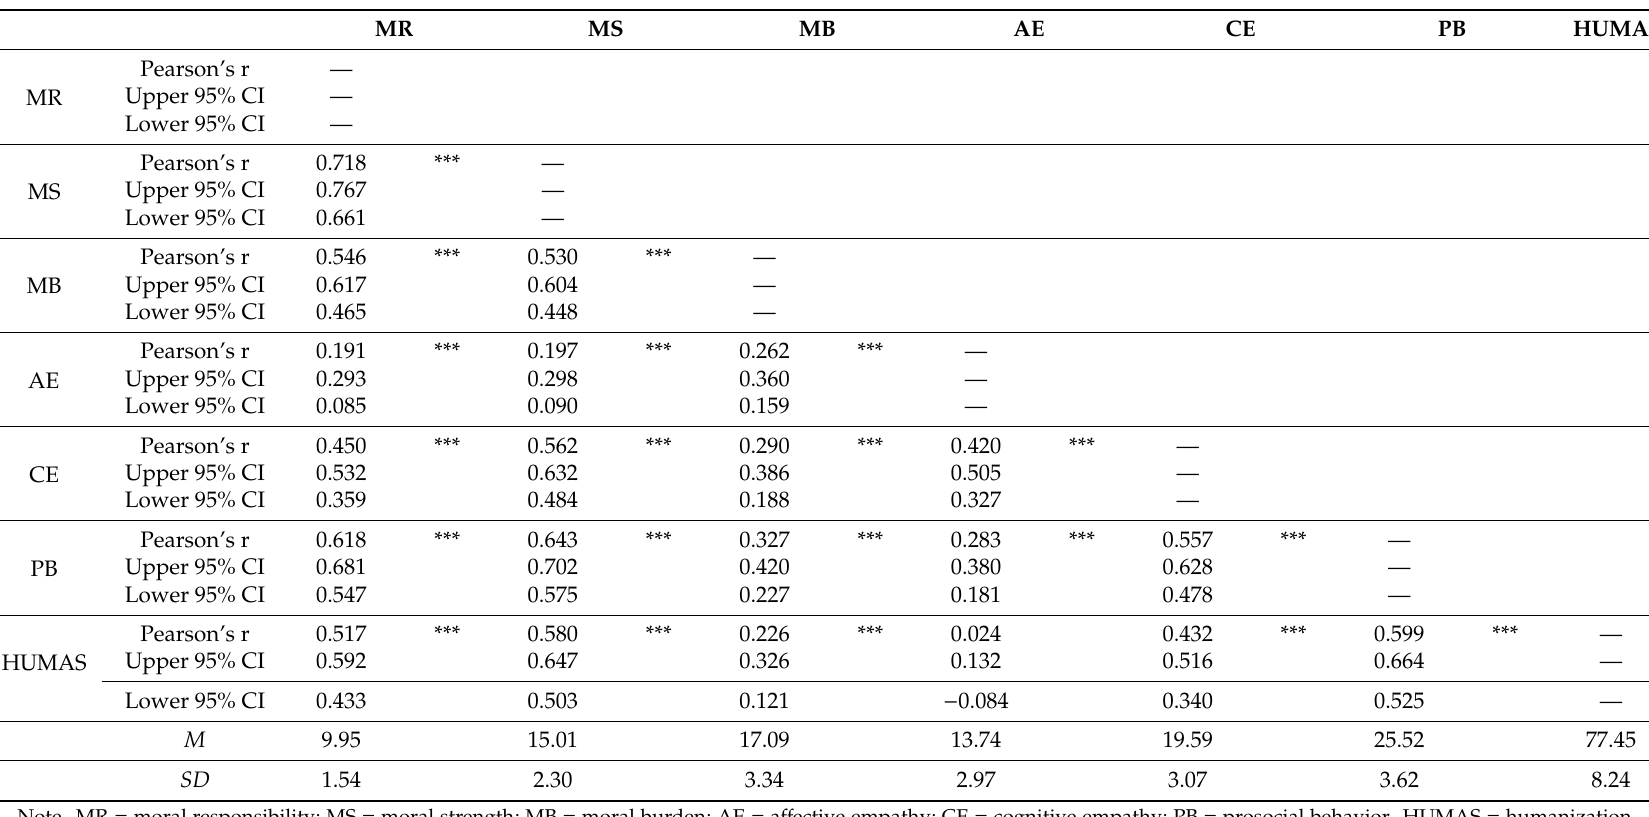
Table 1. Bivariate correlation matrix and descriptive